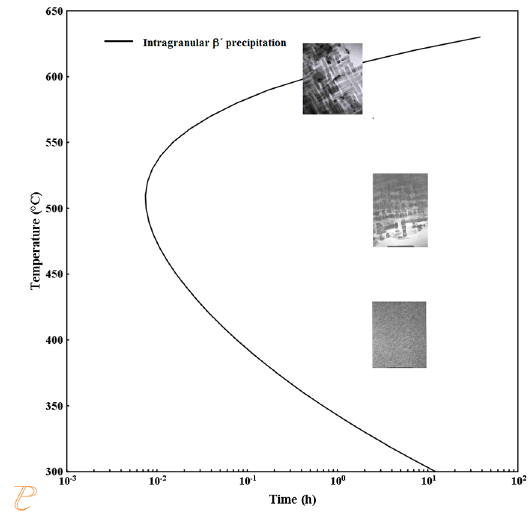
Figure 7. TC-PRISMA calculated TTP diagram.